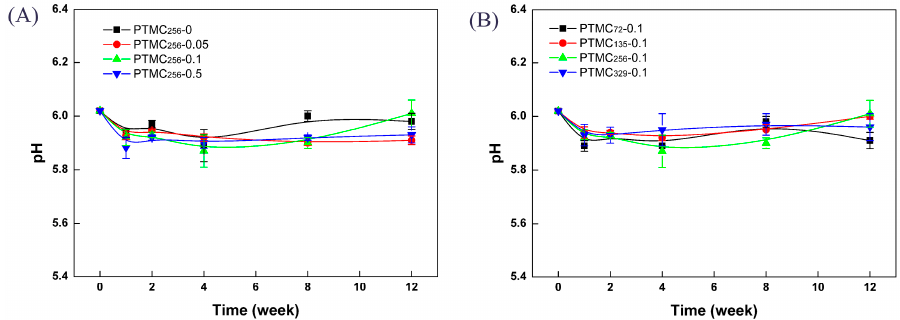
Figure 10. The pH profile of lipase solutions after enzymatic degradation of PTMC-Ns with: different cross-linker amount ( A ); and different initial molecular weight ( B ).